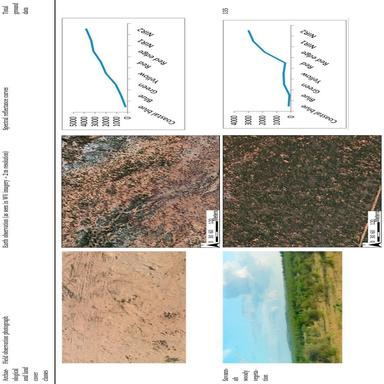
OOB errors of optimised mtry and ntree values using grid search.